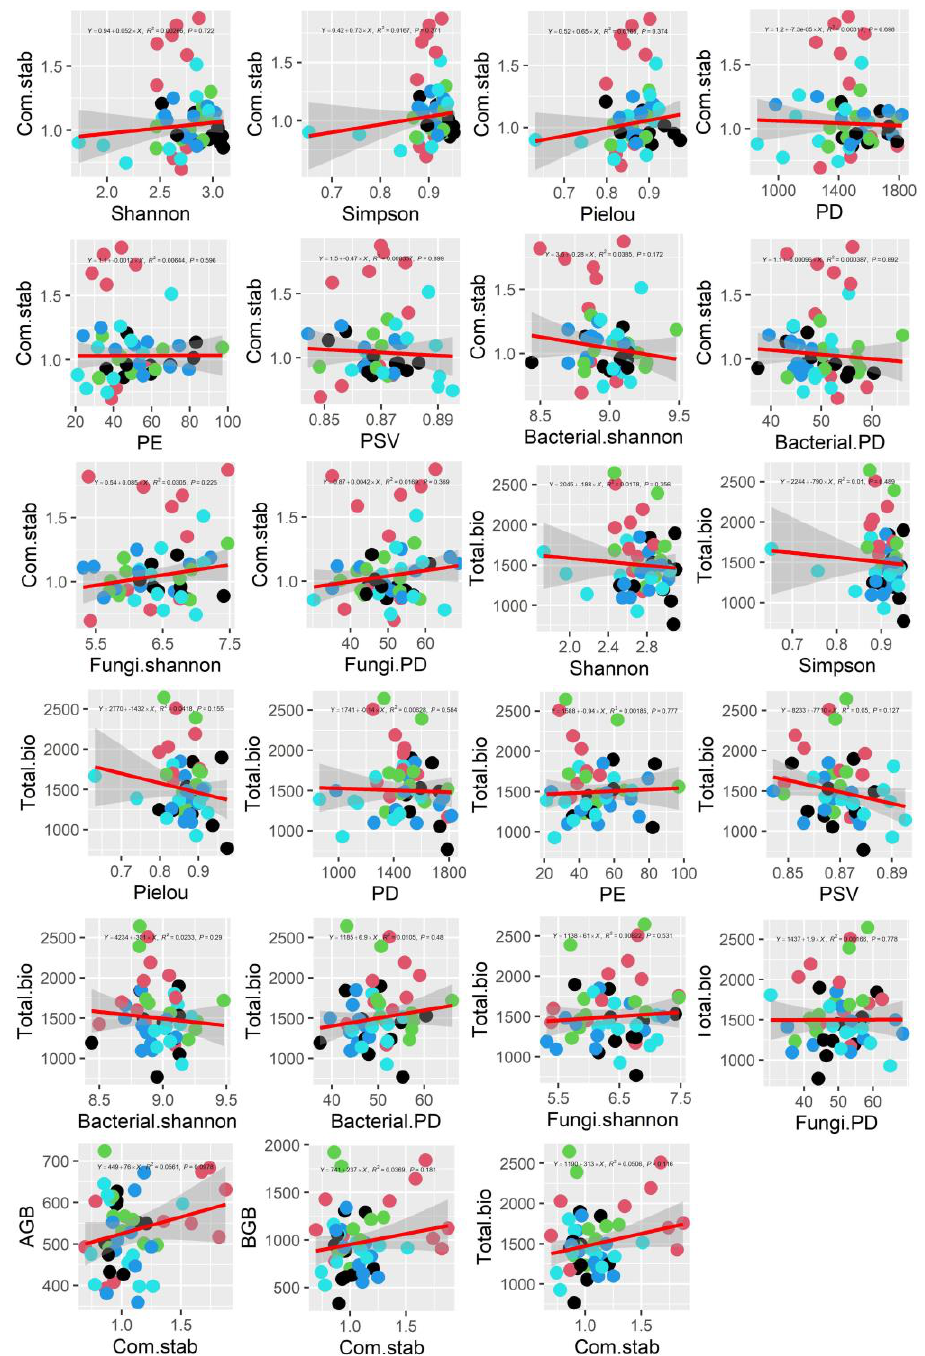
Figure 8. The relationship between biodiversity and biomass and community stability, and the relationship between biomass and community stability. Different colored dots indicate different treatments, gray translucent areas indicate 95% confidence intervals. Shannon, Simpson and Pielou indicate different indices of diversity. PD, PE and PSV indicate phylogenetic diversity, phylogenetic endemism and phylogenetic species variability, respectively. AGB and BGB denote aboveground biomass and belowground biomass. Com.stab indicates community stability.